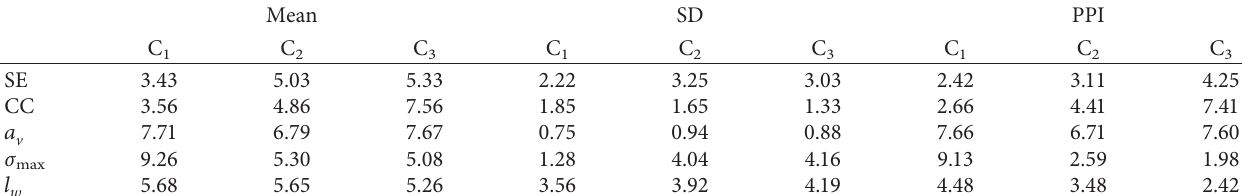
Table 5: Profile analysis for the performance parameters across all the specimens (nondimensional data).